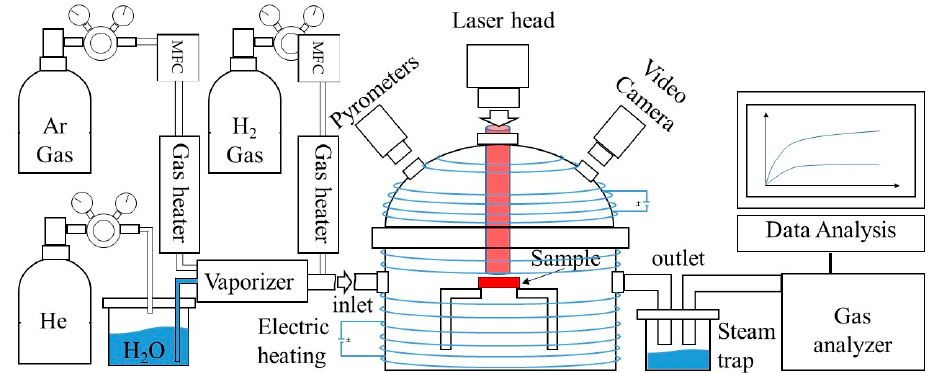
Figure 9. Schematic of the laser heating facility (LAHF) [47].